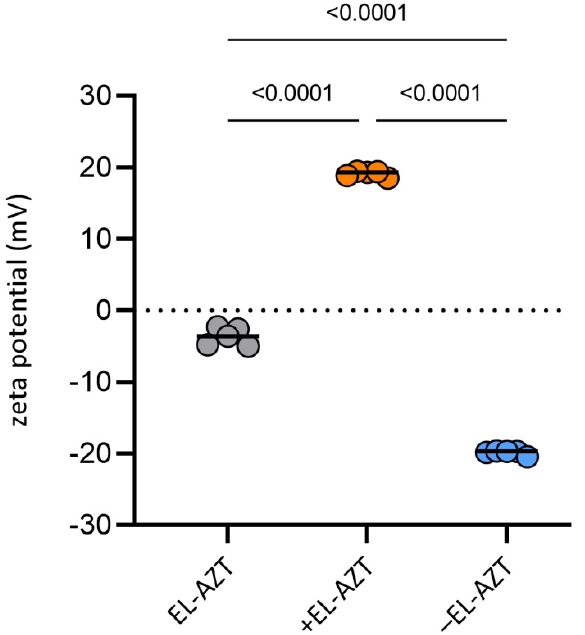
Figure 2. Zeta potentials of the different surface-charged AZT-liposomes. Data are mean and individual values ( n = 5). Statistically significant differences with p values are shown. Statistical analysis was performed by one-way ANOVA with post-hoc Tukey test. EL-AZT, neutral liposomes with azithromycin; +EL-AZT, cationic liposomes with azithromycin; − EL-AZT, anionic liposomes with